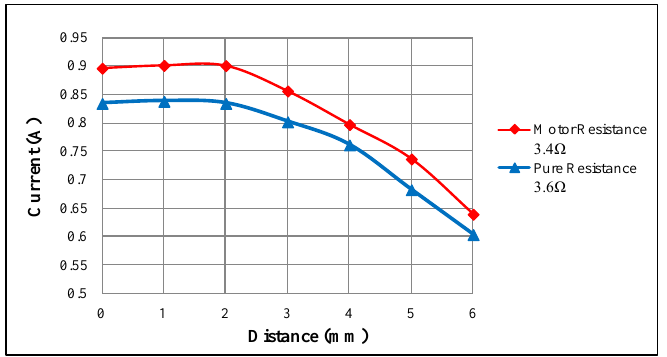
Figure 22. Current-distance curves of the single-phase switched reluctance motor and pure resistance loads.